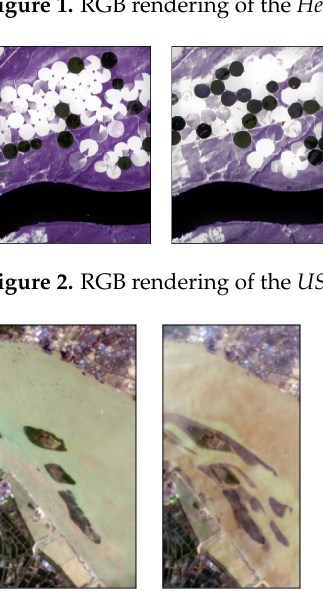
Figure 1. RGB rendering of the Hermiston dataset scenes.